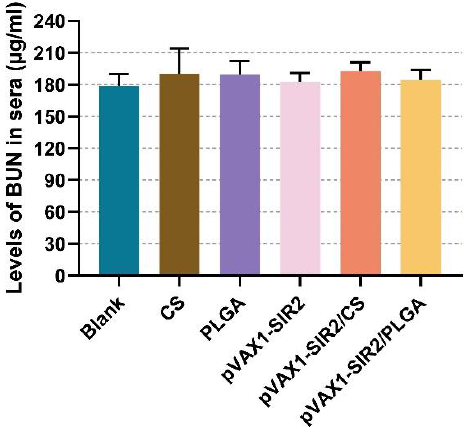
Figure 4. Toxicity analysis of PLGA and chitosan nanospheres loaded with pVAX1-SIR2 plasmids. Five serum samples from each group were separated and the levels of BUN were investigated by values were analyzed by one-way ANOVA analysis followed by Dunnett’s test. Values were shown as mean ± SD ( n = 5).